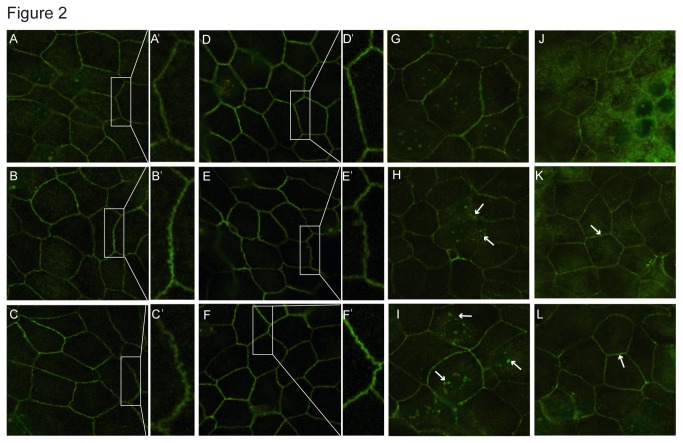
Arsenic alters the localization of tight junction proteins in MTE cell monolayers.After a 5-day arsenic exposure immunofluorescent stains for Cl-1 resulted in altered patterns of localization at cell-cell contact sites: (A, A′) 0 As; (B, B′) 0.8 μM As; and (C, C′) 3.9 μM As. A′, B′, and C′ are magnified views of boxed regions from A, B, and C, respectively. A similar alteration was observed in occludin staining following arsenic exposure: (D, D′) 0 μM As; (E, E′) 0.8 μM As; and (F, F′) 3.9 μM As. Cl-4 preparations displayed increased cytosolic punctate staining (white arrows) following arsenic exposure: (G) 0 As; (H) 0.8 μM As; and (I) 3.9 μM As. Cl-7 preparations displayed an increased staining following arsenic exposure (white arrows highlight brighter staining at cell-cell borders): (J) 0 As; (K) 0.8 μM As; and (L) 3.9 μM As.